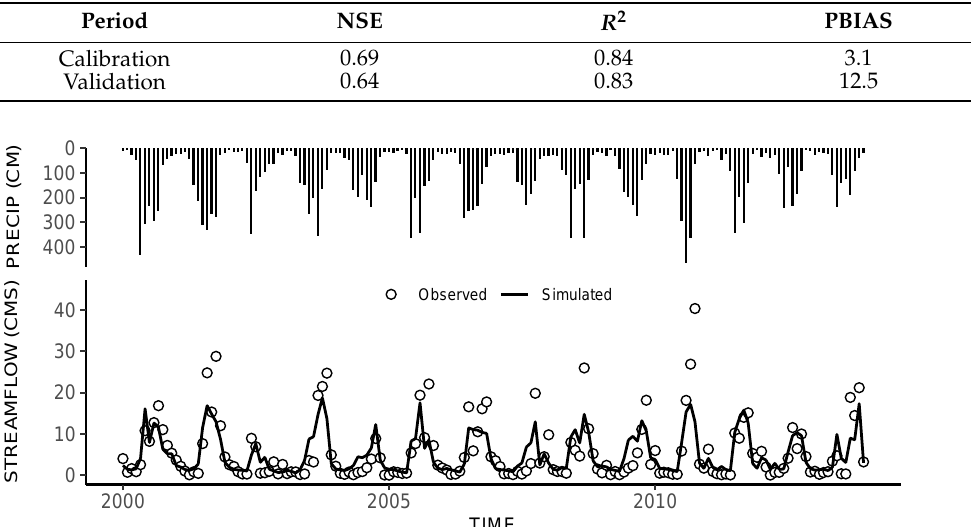
Table 3. Observed vs simulated streamflow goodness of fit